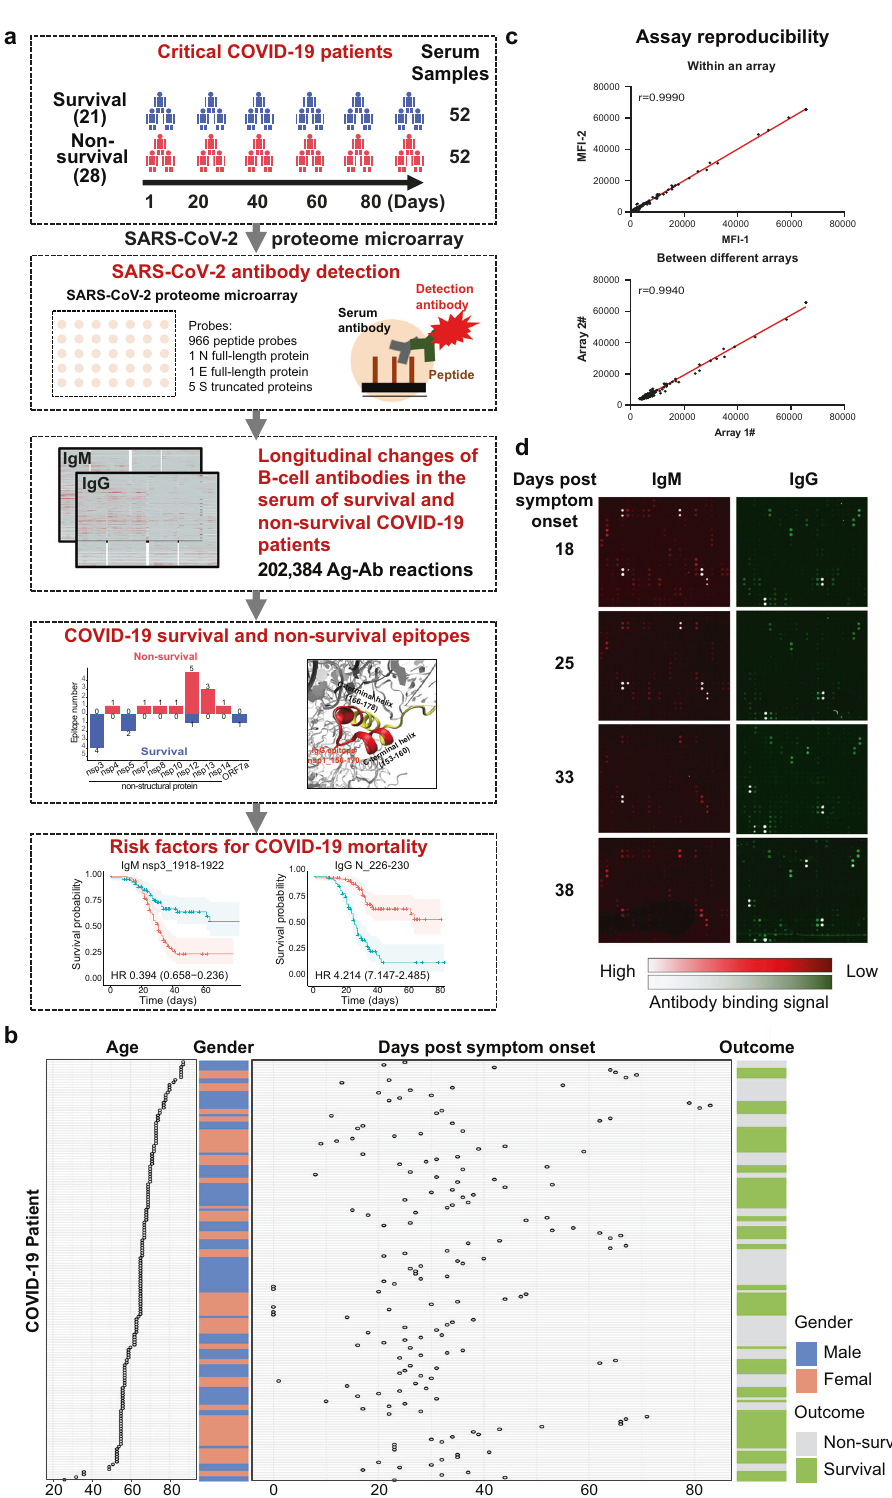
Fig. 1 Detection of SARS-CoV-2 serum antibodies in critical COVID-19 patients. a Work fl ow of the longitudinal analyses of SARS-CoV-2 proteome antibodies in the serum of critical COVID-19 patients. b Characteristics of the COVID-19 patients in this study. c The reproducibility of serological antibody detection using the SARS-CoV-2 proteome microarray within an experiment and between different experiments. The r correlation was calculated within an array and between different arrays. d Representative fl uorescent image of antibody detection using serum from a COVID-19 patient who did not survive at different days post symptom